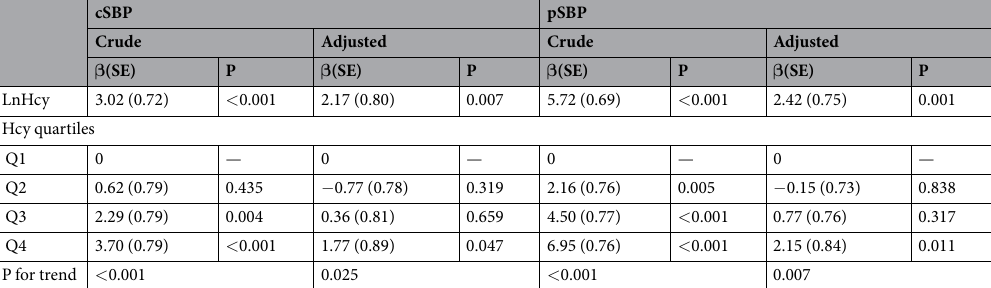
Table 2. Univariate and multivariate linear regression for effects of Hcy on cSBP and pSBP. Abbreviations: Hcy, homocysteine; cSBP, central systolic blood pressure; pSBP, peripheral systolic blood pressure. Adjusted: age, sex, body mass index, smoking status, drinking status, serum creatinine, diabetes mellitus, dyslipidemia, cardiovascular disease, antihypertension drug